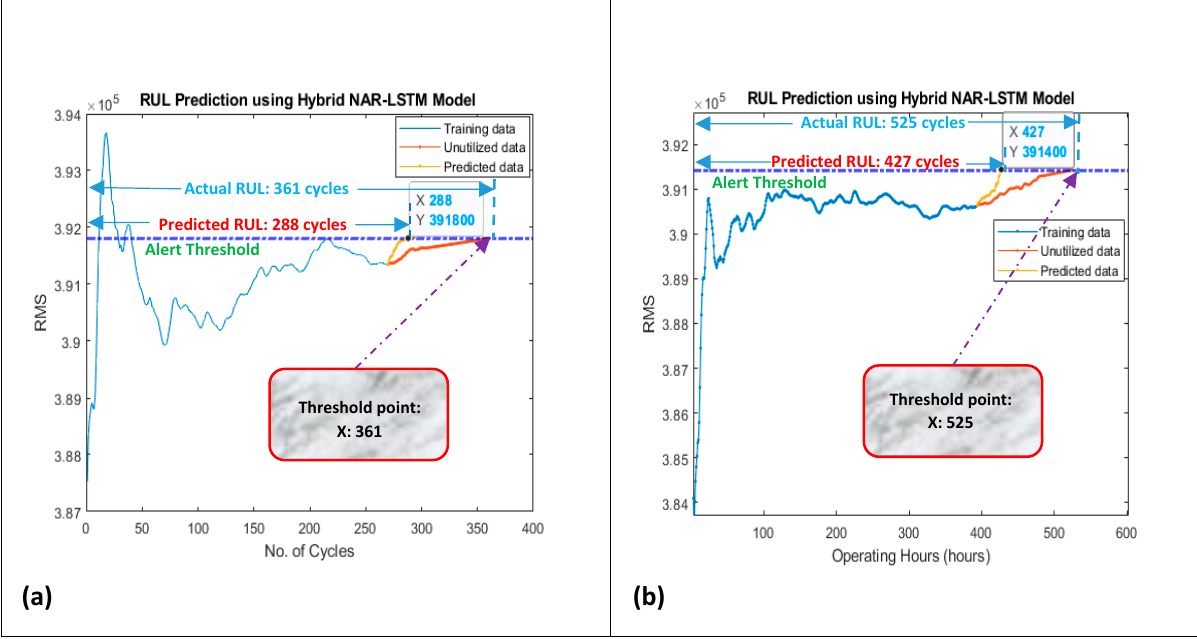
Figure 13. Prediction of overall RUL using 75% data of degradation trends of ( a ) engine No. 140 from FD002 and ( b ) engine No. 25 from FD004, for